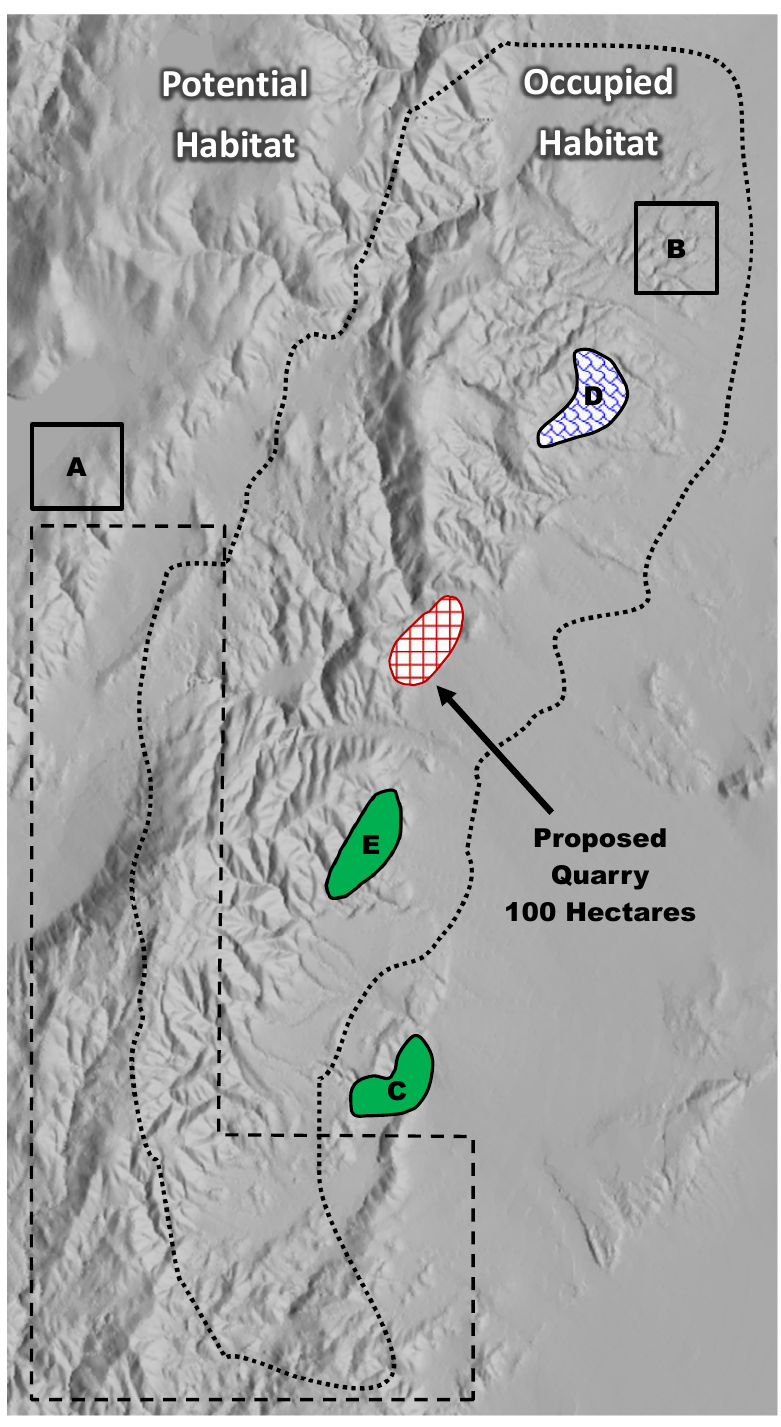
Figure 2. Hypothetical landscape evaluated using the Bighorn Habitat Assessment Tool (BHAT) to compare mitigation alternatives for a proposed hypothetical